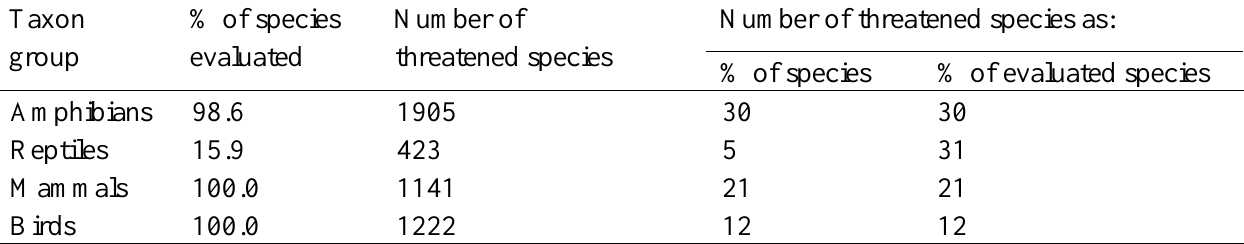
Table 2. (A) Risk comparisons (global). Data from the IUCN (2008).